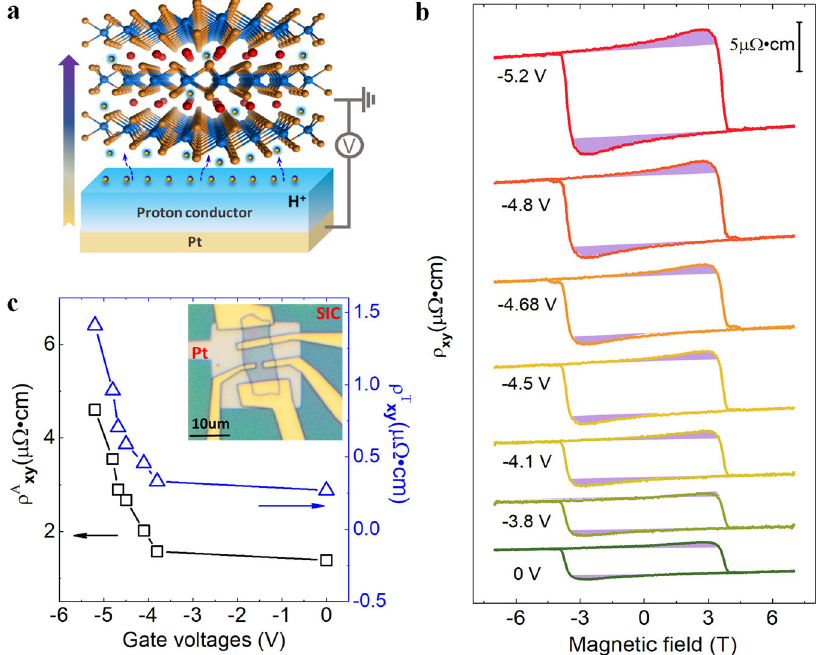
Fig. 3 Gate-tuned anomalous Hall and topological Hall effect in Fe 0.28 TaS 2 nano fl ake. a A schematic of gate-induced proton intercalation. b Hall resistivity under different gate voltages. Topological Hall resistivity ρ T xy are shadowed by the light purple colour. c Gate-dependent anomalous and topological Hall resistivity. Inset: a Hall-bar device on solid ion (proton) conductor